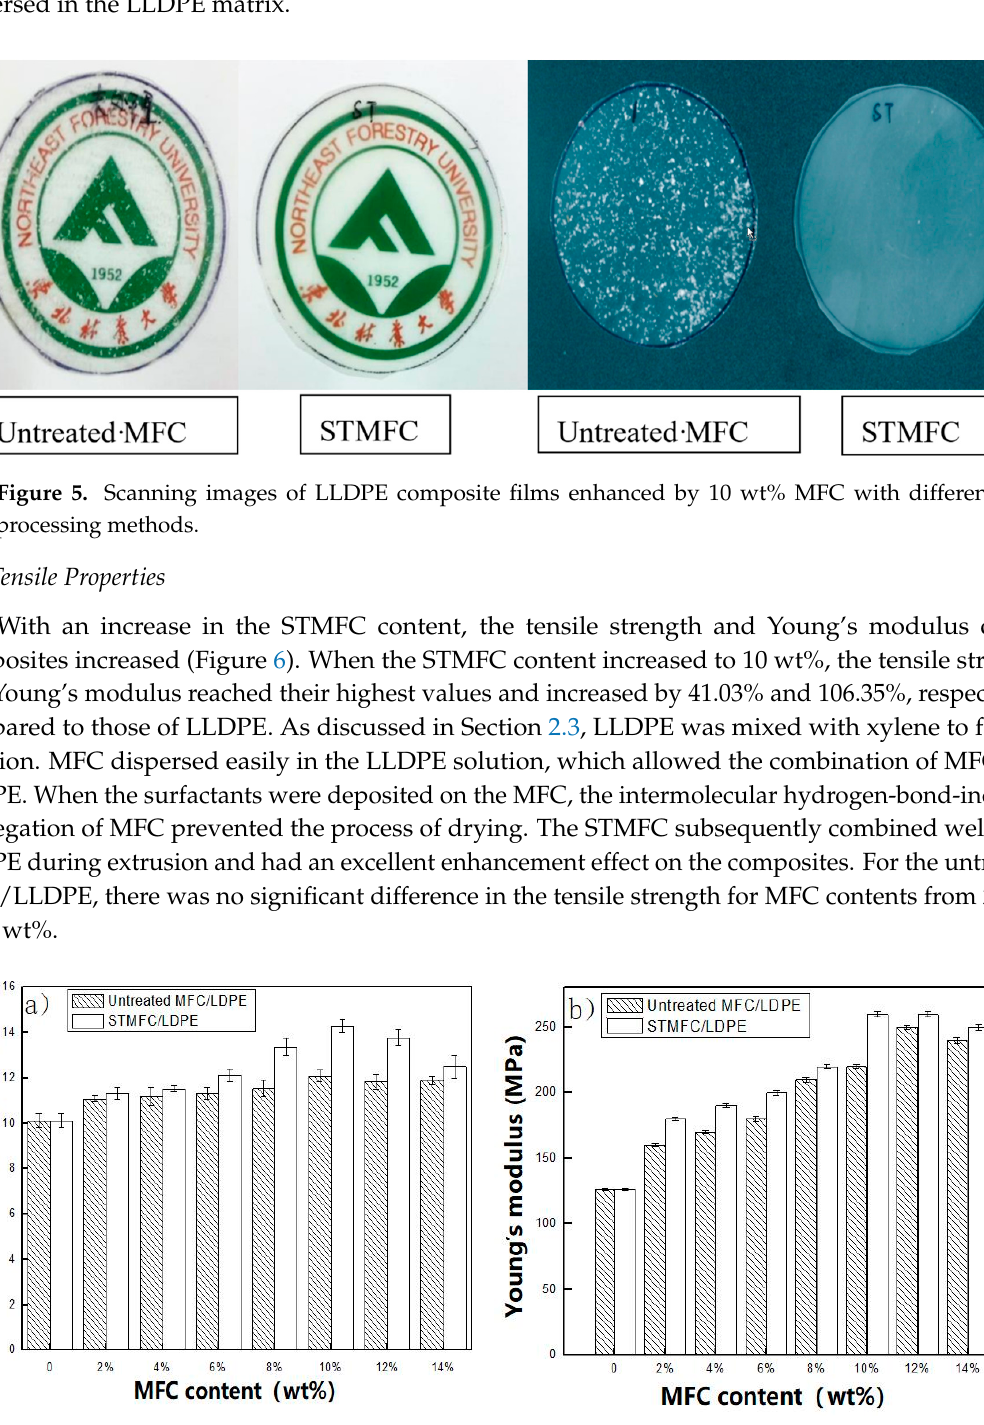
Figure 6. Mechanical properties of surfactant ‐ treated and untreated microfibrillated cellulose ‐ reinforced LLDPE composites with different MFC contents (wt%): ( a ) tensile strength and ( b ) Young’s modulus.